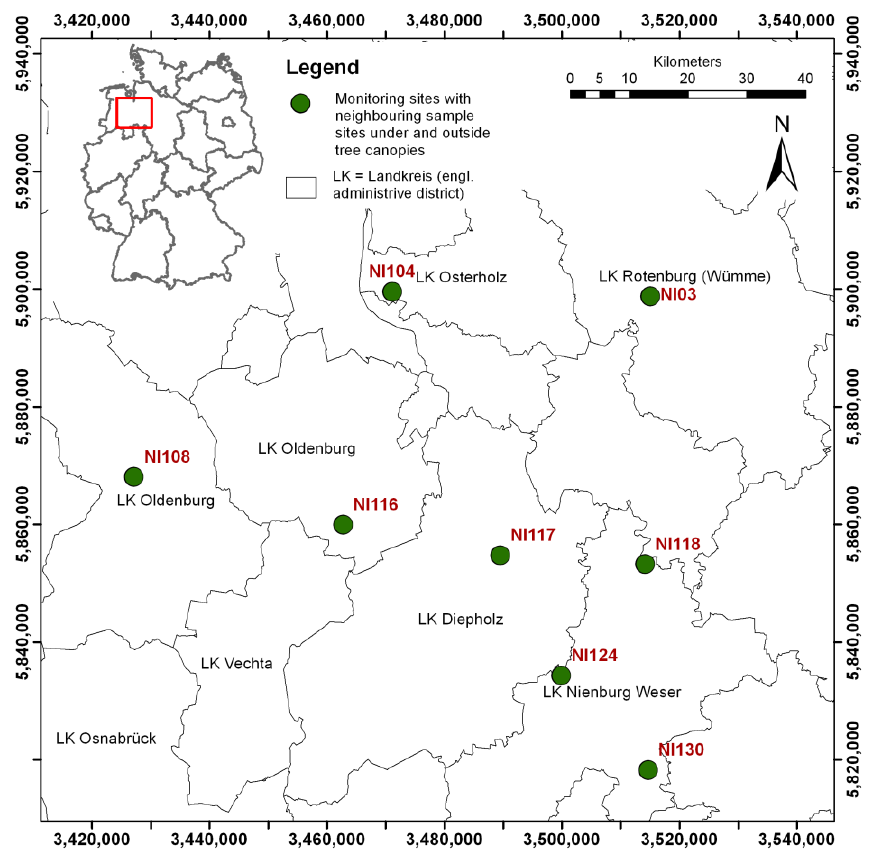
Figure 1. Spatial distribution of the 8 sites in northwest Germany where moss specimens were col- lected from 26 open land and canopy drip plots in 2021.